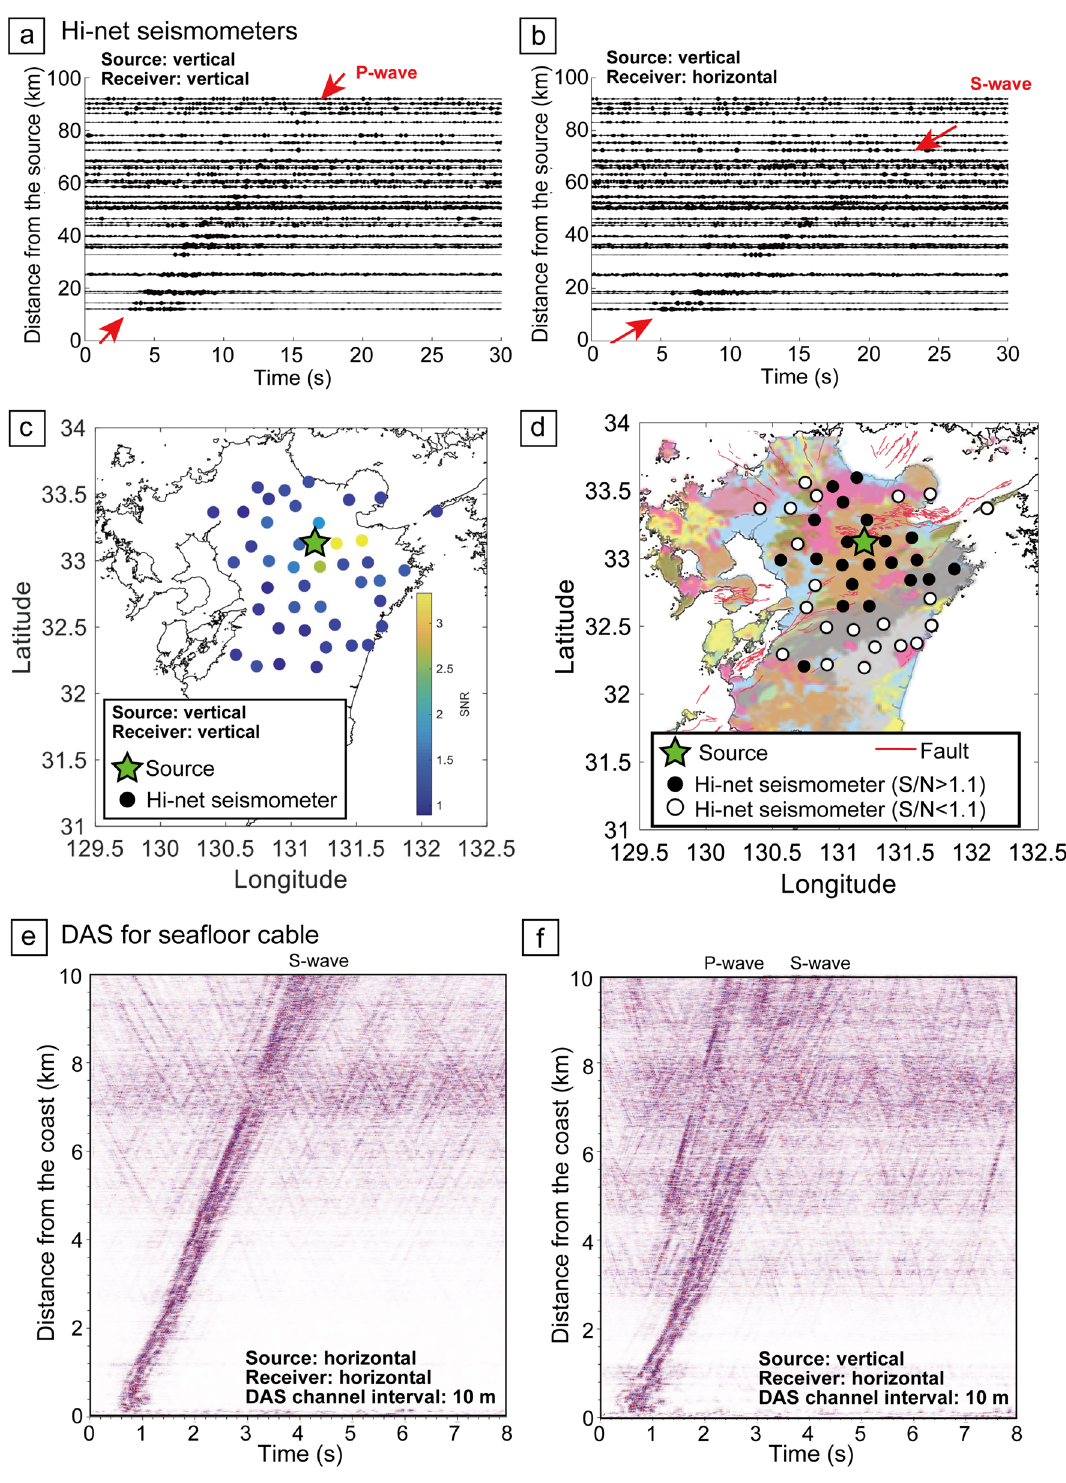
Figure 5. Signal propagation from continuous source system. ( a ) Transfer functions from the vertical source motion and the vertical component of Hi-net seismometers with 2 months of stacking. P-wave was recorded at ~ 80 km distance from the source. ( b ) Transfer functions from the vertical source motion and the horizontal component of Hi-net seismometers. ( c ) Signal-to-noise ratio (SNR) of each seismometer. ( d ) The relationship between lithology and signal-to-noise ratio. The igneous rocks are in pink and brown, and the sedimentary rocks are in other color. The lithological map was from Geological Survey of Japan, AIST, (2015) 44 . We drew the coastline of this map with Generic Mapping Tools 46 . ( e ) Transfer function derived from horizontal motion of the source system and DAS for seafloor cable. ( f ) Transfer function derived from vertical motion of the source system and